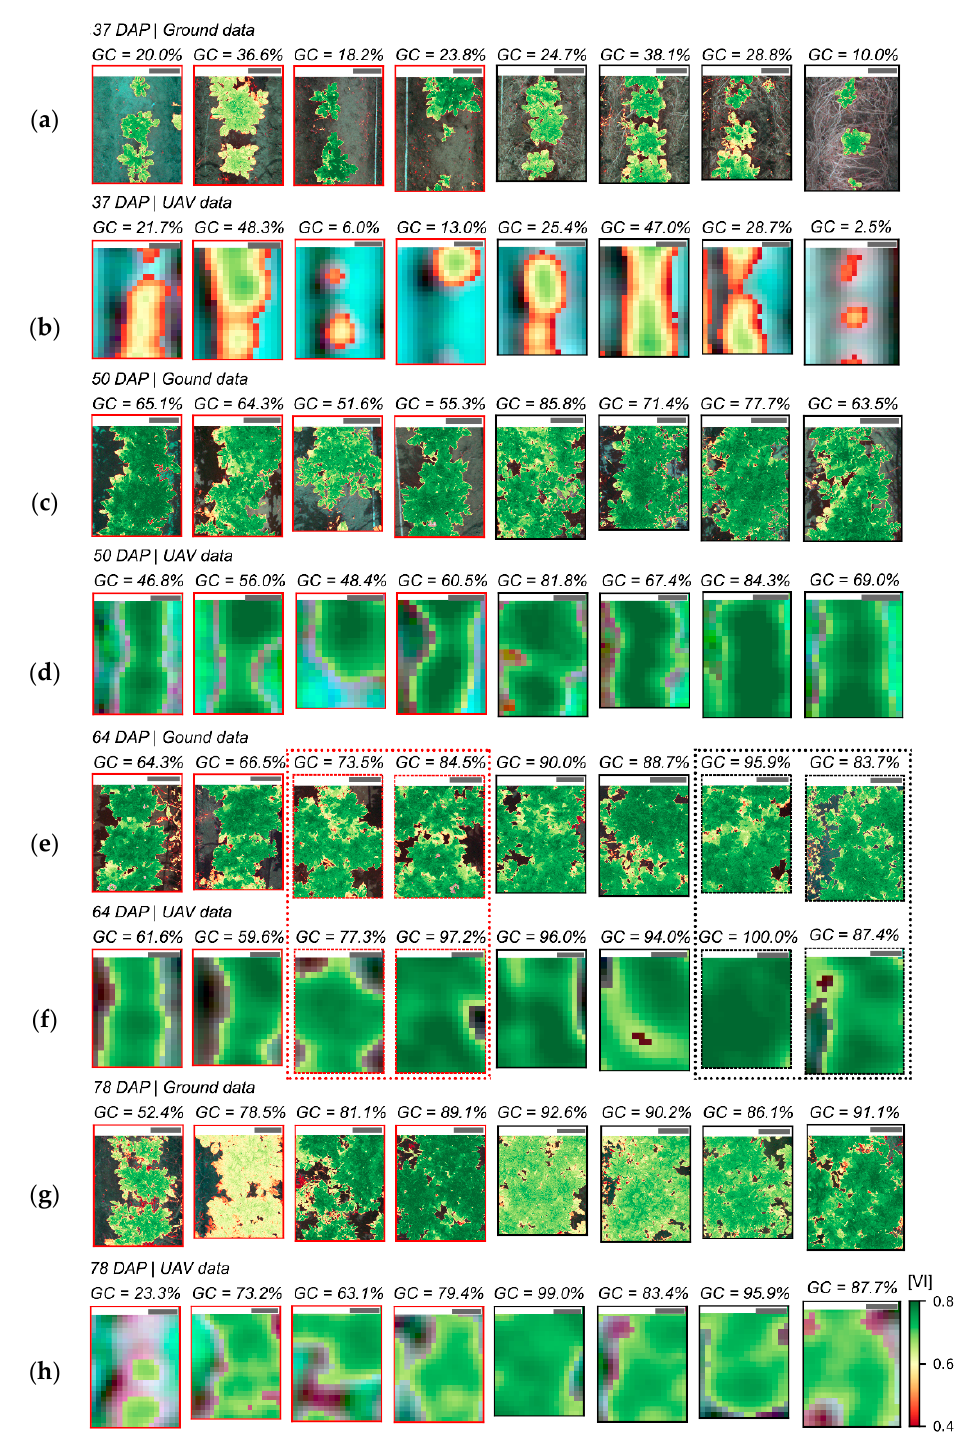
Figure A4. Ground-based ( a , c , e , g ) and UAV ( b , d , f , h ) imagery for SUs over the growing season. SUs cultivated with T1 (“non-mixed”) are represented in red frames and images corresponding to T2 (“mixed”) in black frames. False color composites (828, 660, and 607 nm as RGB for ground-based and nearest bands for UAV images) are displayed on the background and foreground shows OSAVI (VI) after vegetation segmentation. Scale bars (left upper corners) indicate 25 cm. For 64 DAP, frames in dashed lines indicate SUs not measured during other